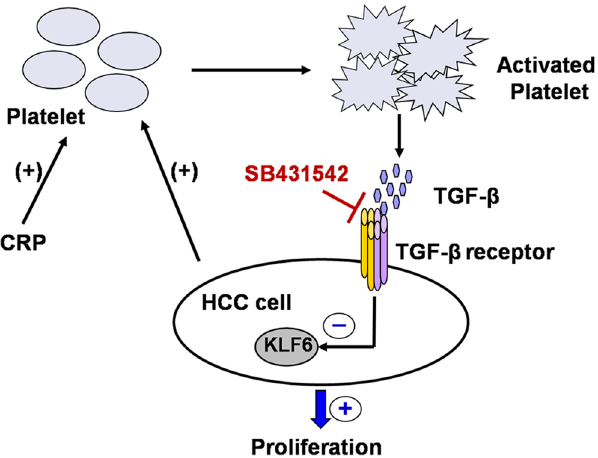
Figure 7. Schematic representation of KLF6-dependent, platelet-induced tumor cell proliferation. The platelet- induced proliferation of HCC cells requires platelet by the platelet-specific agonist CRP or HCC cells. Activated platelets then secrete granules containing cytokines, such as TGF- β , that promote tumor cell growth and mediate the cell cycle and apoptosis of tumor cells by down-regulation of KLF6